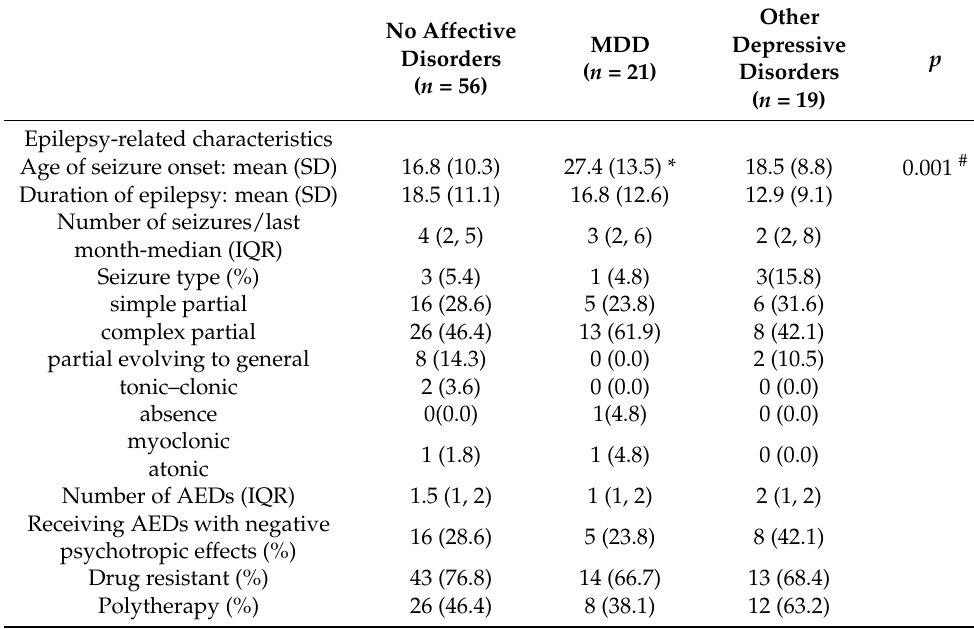
Table 1. Clinical characteristics of subgroups according to the presence of depressive